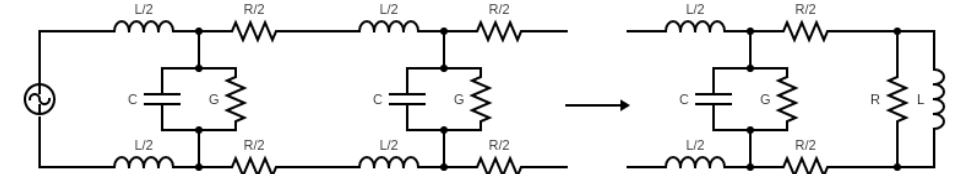
Figure 1. Diagram of electrical circuit model of the vocal tract with inductors, capacitors, resistors, and a shunt conductance terms. The arrow represents the break in the circuit where the rest of the tubelet circuit elements would be. An AC source represents the glottis and the resistor and inductor in parallel on the end represents the radiation